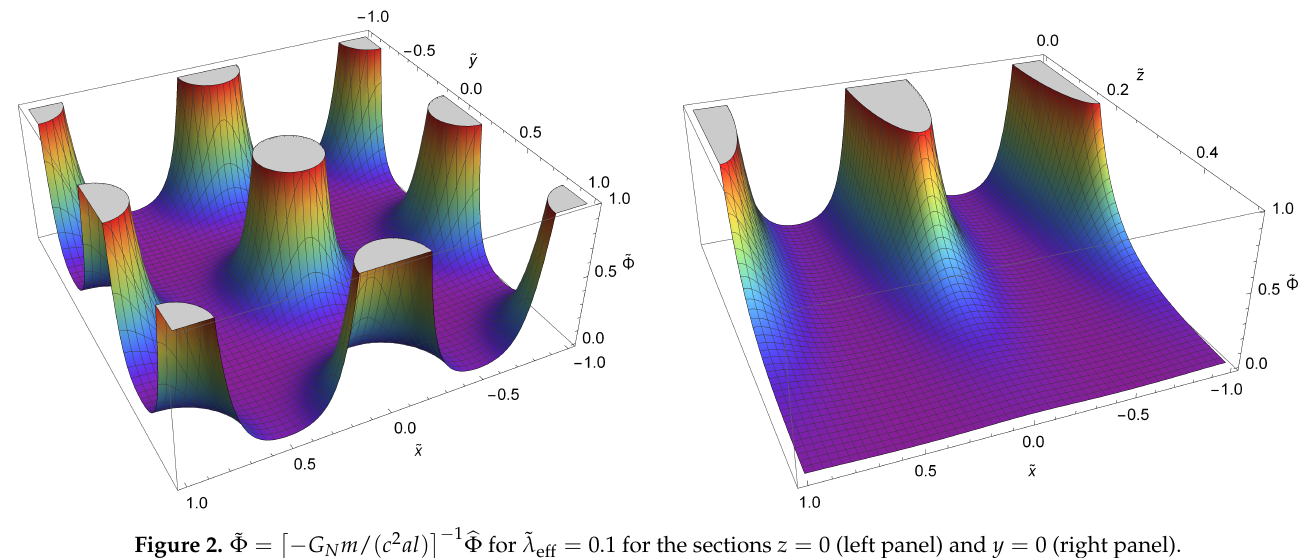
(cid:2) − (cid:3) − 1 G N m / ( c 2 al ) Figure 2. ˜ Φ = (cid:98) Φ for ˜ λ eff = 0.1 for the sections z = 0 (left panel) and y = 0 (right panel).